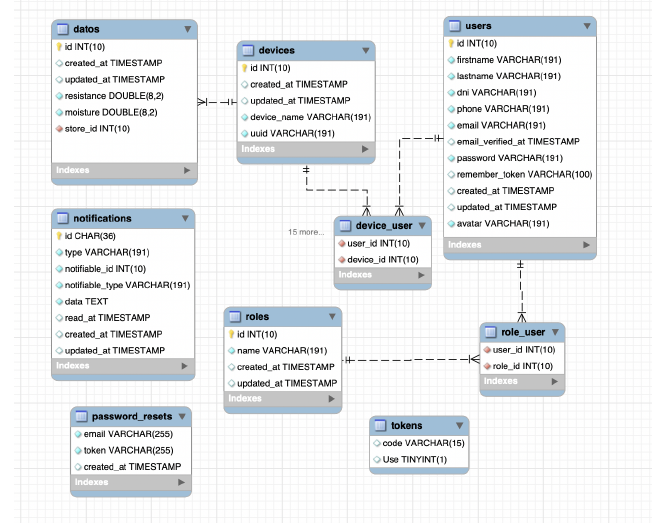
Figure 13. Web application Database design represented by EER diagram.